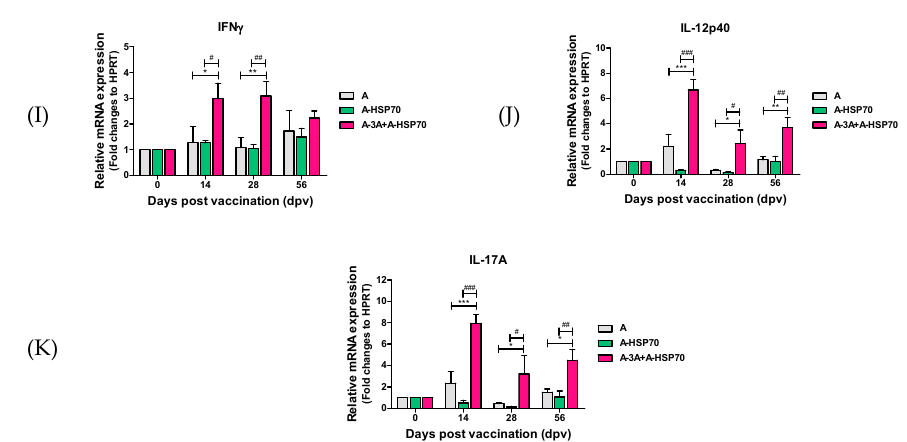
Figure 5. A-3A and A-HSP70 induced co-stimulatory molecule and cytokine gene expression in porcine PBMCs. Porcine peripheral blood mononuclear cells (PBMCs) isolated from the whole blood of vaccinated pigs ( n = 5 / group) individually, as described in Figure 4, were used for the qRT-PCR assay. Gene expression levels were normalized to hprt levels and are presented as a relative ratio compared to control levels. ( A – K ) represent: gene expression levels of ( A ) CD40; ( B ) CD80; ( C ) CD86; ( D ) CTLA-4; ( E ) MHC class I; ( F ) MHC class II; ( G ) IFN α ; ( H ) IFN β ; ( I ) IFN γ ; ( J ) IL-12p40; ( K ) IL-17A in porcine PBMCs were analyzed. The data represent the means ± SEM of triplicate measurements ( n = 5 / group). Statistical analyses were performed using one-way ANOVA with Tukey’s post-hoc test. * , # p < 0.05; ** , ## p < 0.01; *** , ### p < 0.001. Animals were monitored daily for body temperature, vaccination site symptoms, and